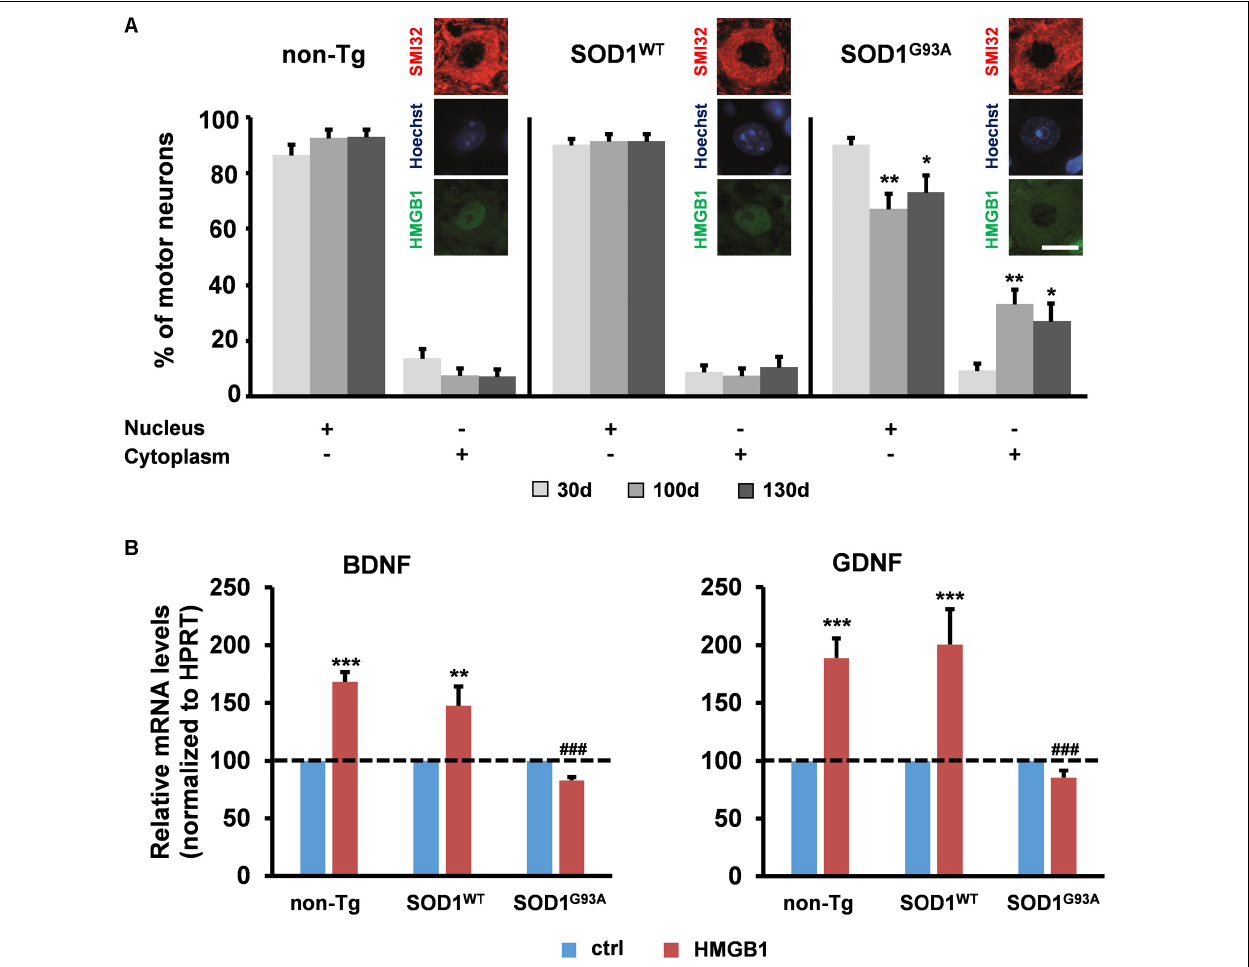
FIGURE 2 | Potential implication of HMGB1 signaling in motor neuron-astrocyte communication in ALS. (A) The number of motor neurons showing HMGB1 into the nucleus or the cytoplasm was determined by immunohistochemistry on spinal cord sections from non-transgenic (non-Tg) or SOD1 WT and SOD1 G93A transgenic mice taken at 30 days (30 days, asymptomatic stage), ∼ 100 days (100 days, onset of motor deficits), and 130 days of age (130 days, symptomatic stage). Data (mean ± SEM) are expressed as percentage of motor neurons with nuclear or cytoplasmic HMGB1 on the total number of analyzed cells. ∗∗ p < 0.01 and ∗ p < 0.05 vs. 30 days SOD1 G93A ; two-way ANOVA, followed by Bonferroni post hoc test, n = 3 mice per age, n = 190–313 motor neurons per genotype and age. Insets are representative immunofluorescent images of spinal cord sections double immunostained for SMI32 (red) and HMGB1 (green); nuclei were stained with Hoechst 33342 (blue). Scale bar, 10 µ m. (B) Expression of BDNF and GDNF was determined in primary astrocytes from the spinal cord of non-Tg, SOD1 WT and SOD1 G93A mice. Cells were exposed to disulfide-HMGB1 (3 µ g/ml) for 6 h. Total RNA was extracted and analyzed by RT-qPCR. Values (mean ± SEM) were normalized relative to HPRT and expressed as percentage of control (ctrl), i.e., the corresponding culture type challenged with saline. ∗∗∗ p < 0.001, ∗∗ p < 0.01 vs. ctrl; ### p < 0.001 vs. HMGB1 in non-Tg and SOD1 WT astrocytes; two-way ANOVA, followed by Bonferroni post hoc test, n = 5–17 experiments, in